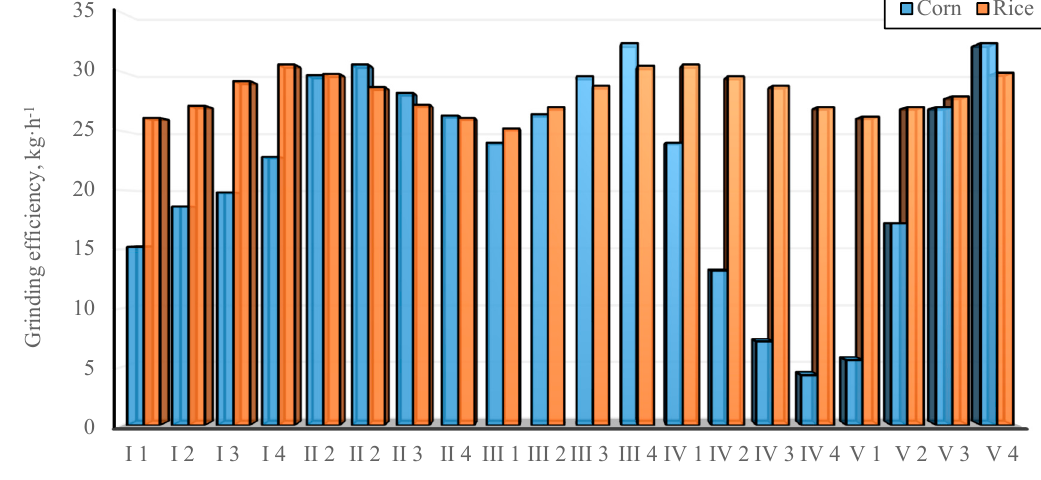
Figure 4. Grinding efficiency for the analyzed settings of the disc angular speeds.